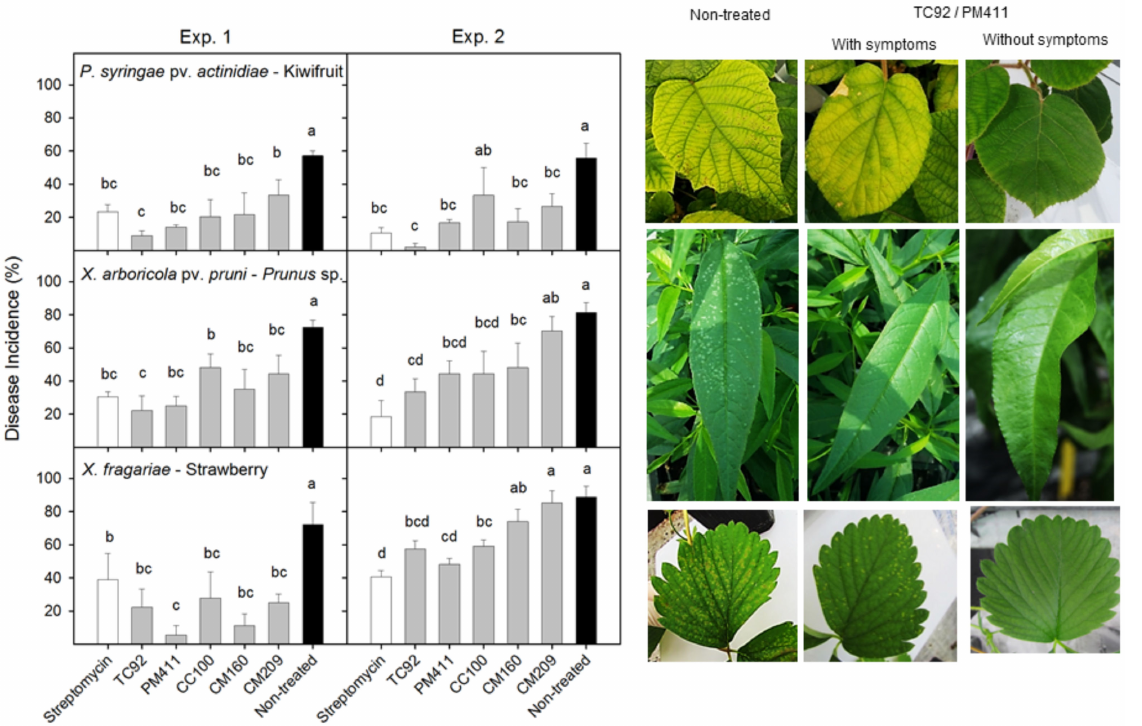
Figure 5. Effect of the treatments with lactobacilli strains (grey bars) on Pseudomonas syringae pv. actinidiae , Xanthomonas arboricola pv. pruni , and Xanthomonas fragariae infections in kiwifruit, Prunus, and strawberry plants, respectively, under greenhouse conditions. The effect of strains on disease incidence (%) was compared with streptomycin (white bars) and a non-treated control (black bars). Different letters indicate statistical significance (Reproduced from